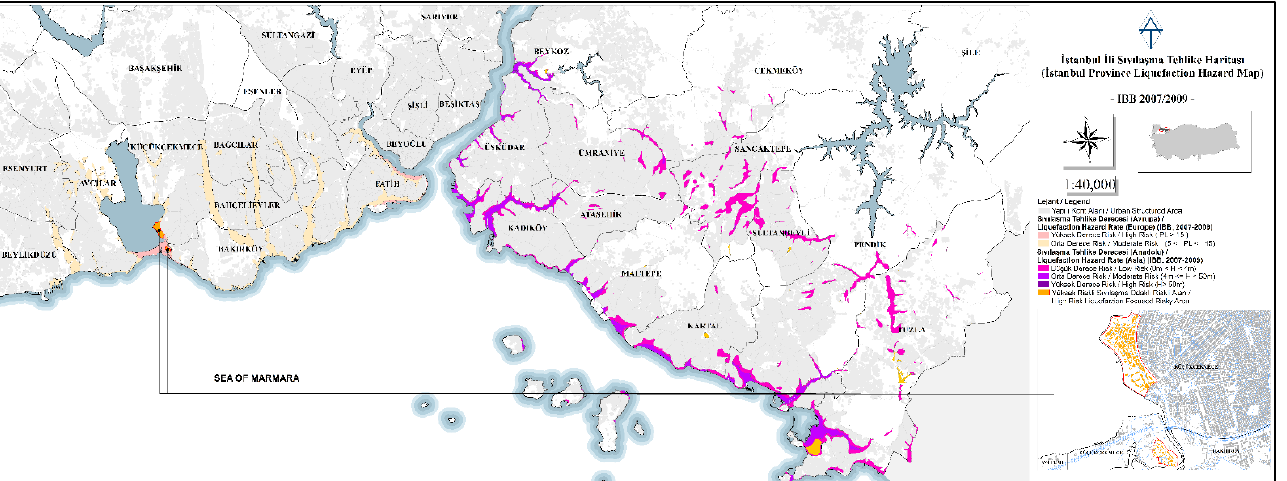
Figure 12. Istanbul Province Buildings under Flooding Risk Map.